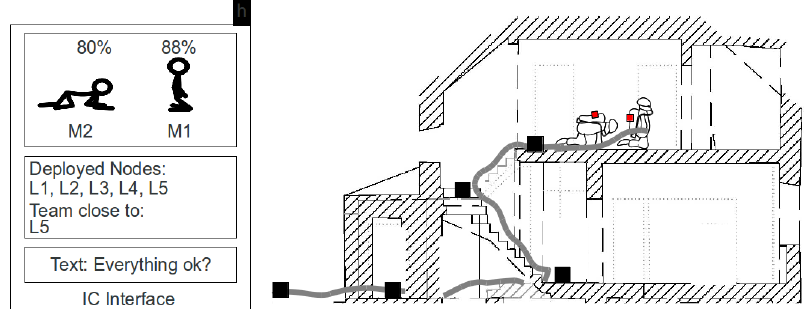
Figure 3. Right : Firefighters with a water hose (gray) deploy WSN nodes (large boxes) during reconnaissance. Sensor units (small boxes) are attached to the SCBAs to recognize their activities and provide a simple message interface. Left : Activities, probability values, node and firefighter sensor information and messages are relayed to the IC tablet using the ad-hoc